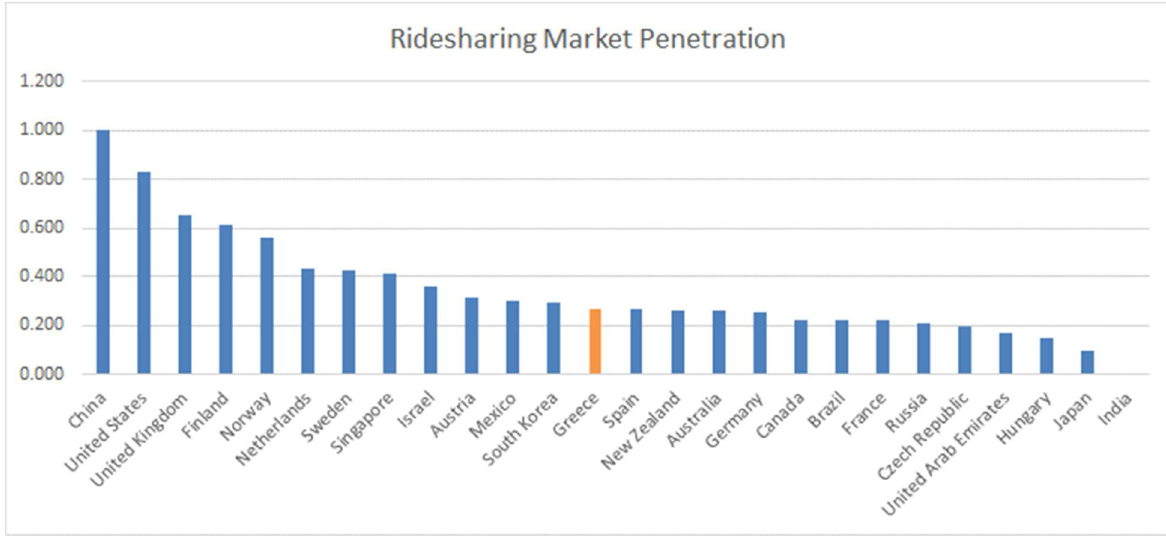
Figure 5. Greece’s AVRI listing in Pillar IV—Ridesharing market penetration.